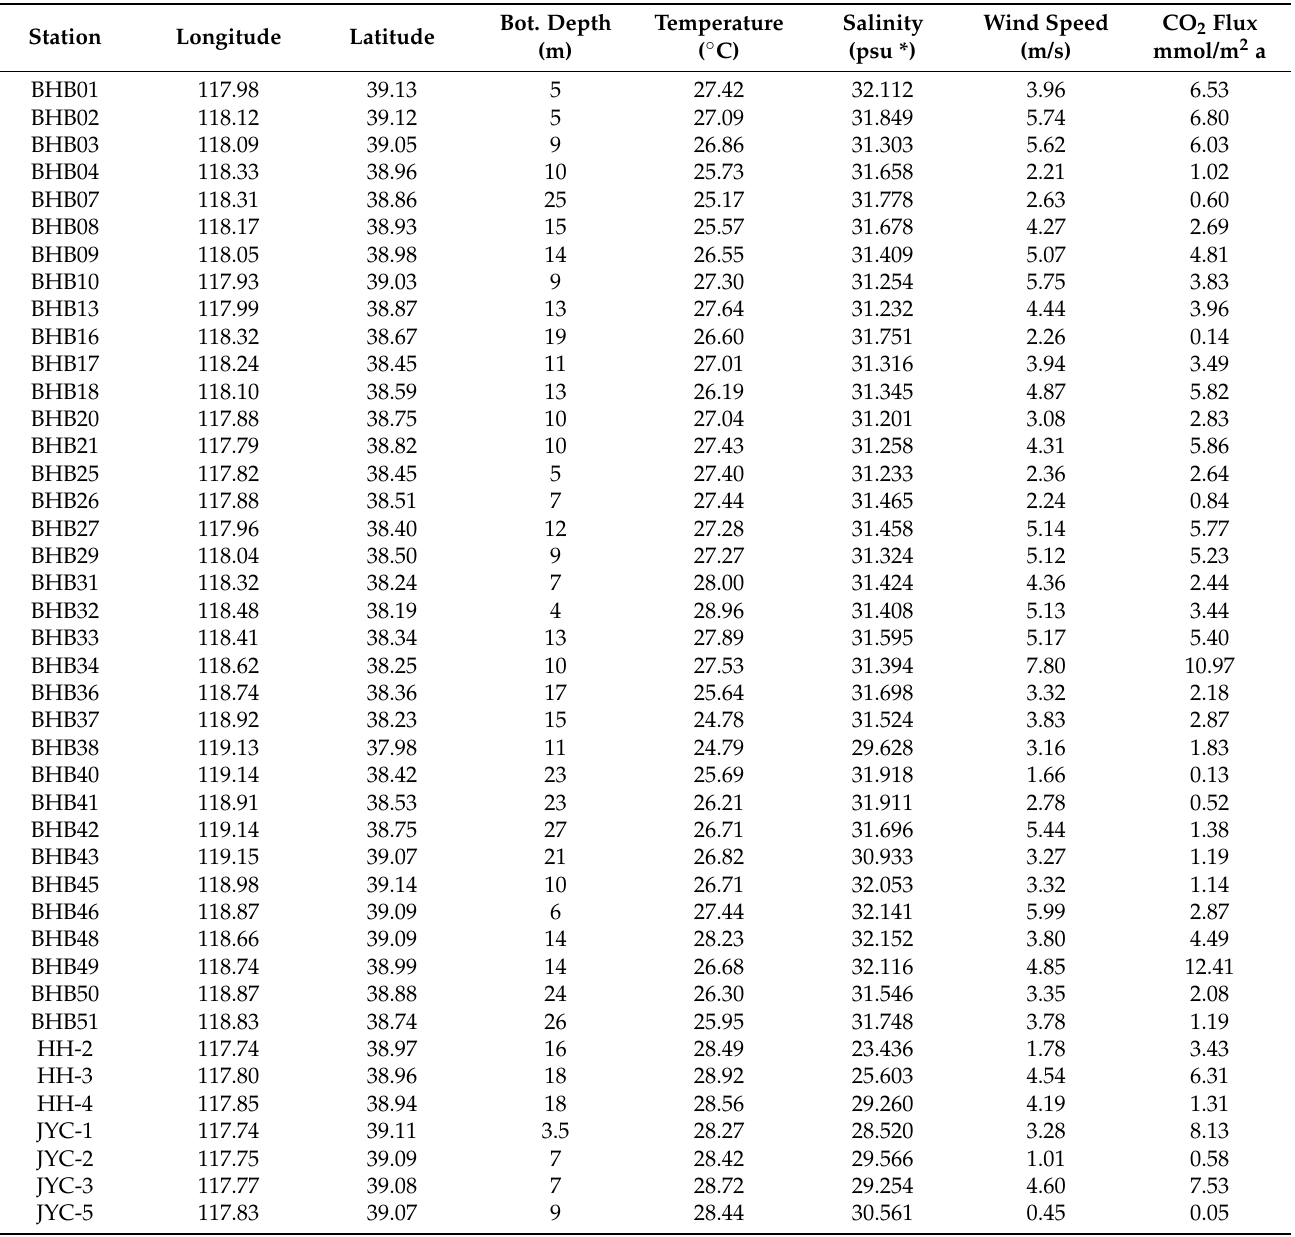
Table 1. Description of sampling stations and CO 2 air–sea fluxes in Bohai Bay in